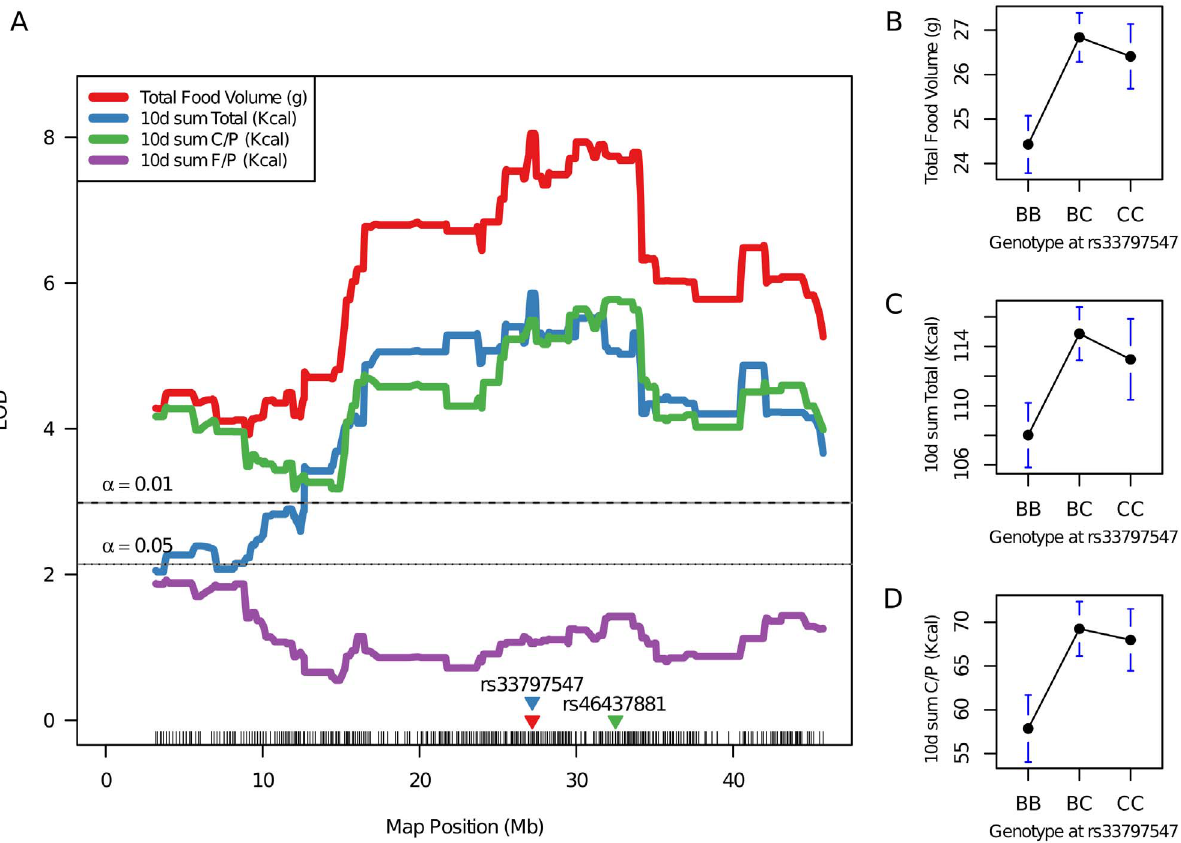
Figure 3. Preferential carbohydrate and total food intake is controlled by Mnic1 and Kcal/Tfv1 loci, respectively. Legend: Interval plot of proximal Chr 17 illustrates fine-mapped QTL for carbohydrate intake ( Mnic1 ), total calorie intake ( Kcal2 ) and total food volume consumed ( Tfv1 ) in B6.CAST-17.1 subcongenic F 2 mice (left) and uncorrected phenotypic means for the peak marker of each QTL (right). Significance threshold values established for a =0.01 and a =0.05 were LOD scores of 2.98 and 2.14, respectively, as determined by 1,000 permutation tests. On the interval map, locations of markers nearest the peak LOD scores are shown on the x-axis, e.g., rs33797547 . On the right, genotype effect plots at marker rs33797547 show the CAST (CC) allele is associated with a higher intake of g, total kcal, and carbohydrate/protein kcal compared to the B6 (BB) allele, and the F1 (BC) responses for all three phenotypes resembled those of the CC, indicating dominance of the CAST allele. Values are mean 6 SEM. See Table 2 for a list of all QTLs.